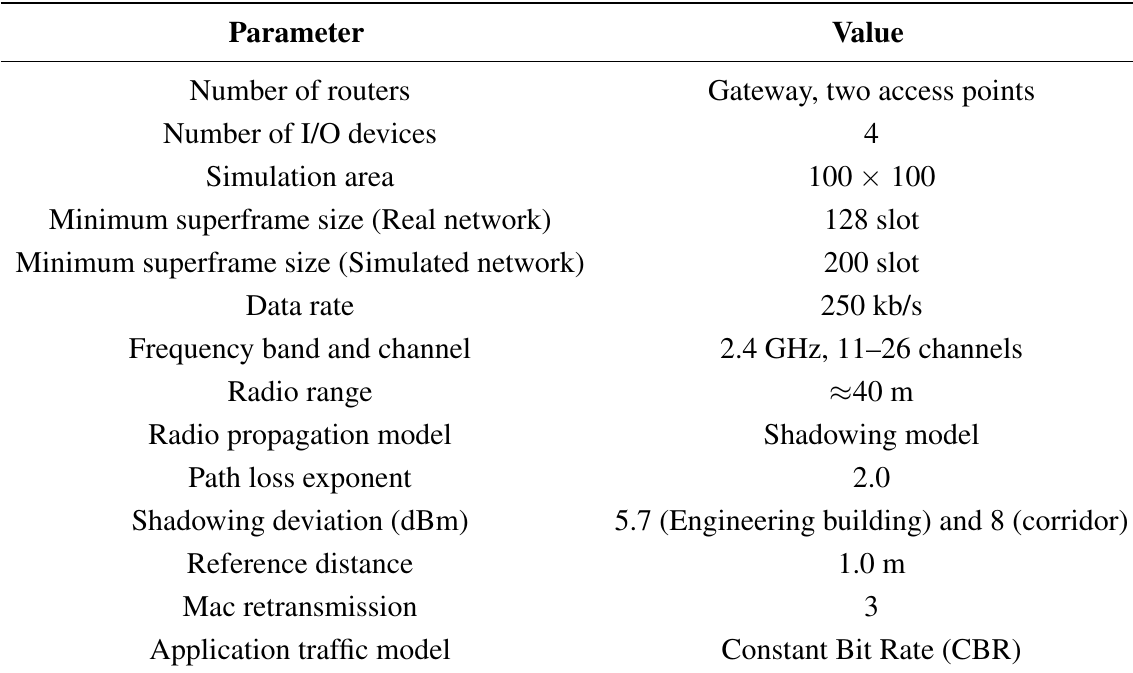
Table 2. NS-2 simulation